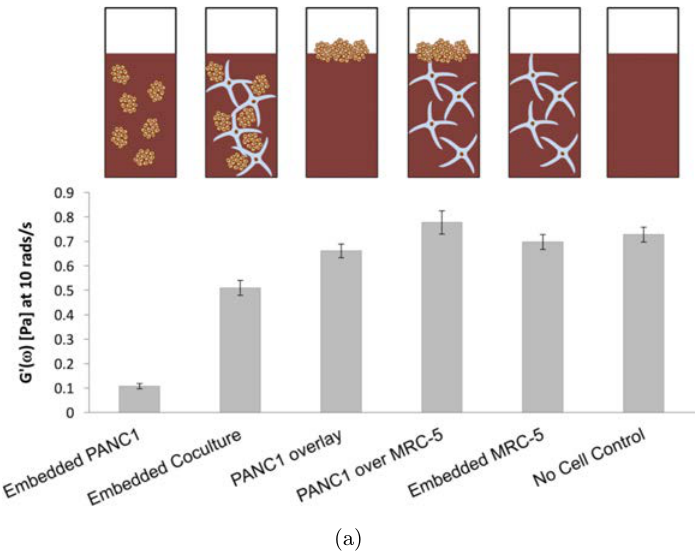
Fig. 5. (a) Comparison of the real component of the complex shear modulus, G 0 , measured in each condition, at 10 Hz. The embedded PANC1 homoculture (no ¯broblasts) samples display signi¯cantly lower shear modulus relative to other co-culture conditions and geometries. (b) Plots estimated from GSER of the full frequency dependence of the storage ( G 0 , ¯lled circles) and loss ( G ", empty circles) moduli for each of the six di®erent culture